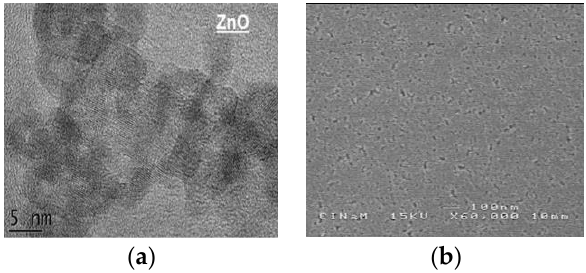
Figure 1. ( a ) TEM image of ZnO nanospheres at 30 mg/mL with 0.2% ethanolamine and ( b ) SEM image of a spin-coated ZnO thin film as S2 and post-annealed at 80